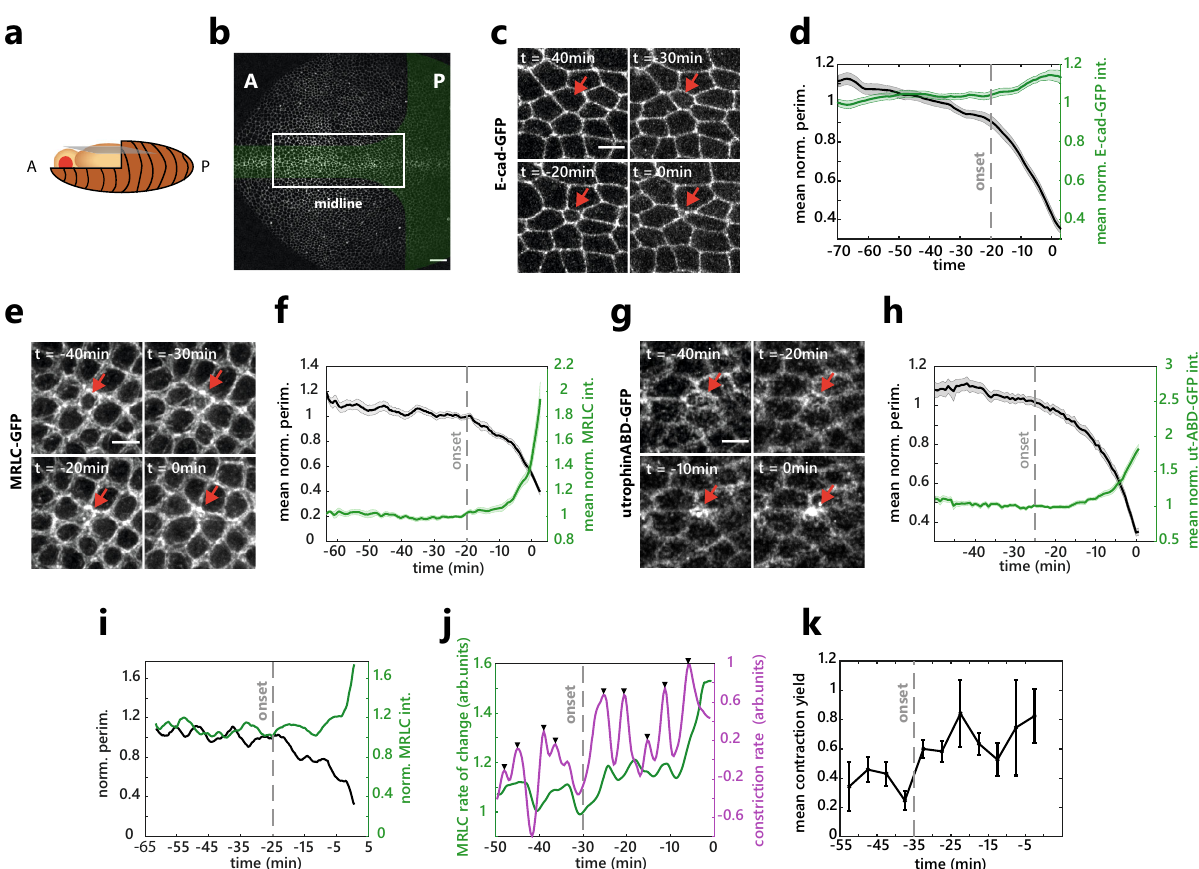
Fig. 1 Actomyosin modulation is not responsible for the initiation of cell extrusion. a Schematic of a Drosophila pupae. A: anterior, P: posterior. b Notum at 16 h after pupal formation (APF). Green zone: domains with a high rate of cell elimination, white rectangle: midline region. A: Anterior, P: Posterior. Scale bar, 25 µ m. c Snapshots of E-cad-GFP during cell extrusion. The red arrow shows an extruding cell. t 0 , time of extrusion termination (apical area = 0). Scale bar, 5 µ m. d Averaged and normalised E-cad-GFP junctional signal during cell extrusion (green) and cell perimeter (black), light colour areas are SEM. The curves were aligned temporally by using the extrusion termination time point (see “ Methods ” ). The grey dotted line represents the onset of extrusion marked by the in fl ection of the perimeter curve (see “ Methods ” ). N = 2 pupae, n = 27 cells. e Snapshots of sqh-GFP (MRLC) during cell extrusion. The red arrow shows an extruding cell. t 0 , time of extrusion termination. Scale bar, 5 µ m. f Averaged normalised sqh-GFP (MRLC) total signal (medial + junctional) during cell extrusion (green) and cell perimeter (black). The grey dotted line is the onset of extrusion, light colour areas are SEM. N = 2 pupae, n = 15 cells. g Snapshots of actin during cell extrusion (utrophin Actin-Binding domain fused to GFP, utABD-GFP). Red arrow points at an extruding cell. t 0 , time of extrusion termination. Scale bar, 5 µ m. h Averaged normalised utABD-GFP total signal (medial + junctional) during cell extrusion (green) and cell perimeter (black). Grey dotted line represents the onset of extrusion, light colour areas are SEM. N = 2 pupae, n = 37 cells. i Single-cell representative curve of sqh-GFP (MRLC) total signal (green) and perimeter (black) showing MRLC pulsatility and perimeter fl uctuations before and during cell extrusion. Grey dotted line represents the onset of extrusion. j Single-cell representative curve of sqh-GFP (MRLC) intensity rate of change (i.e., derivative, green) and the perimeter constriction rate (derivative of the perimeter, magenta). Black arrows show contraction pulses. Grey dotted line represents the onset of extrusion. k Averaged contraction yield (ratio of the constriction rate over MRCL junctional intensity) calculated in 5 min time windows (see “ Methods ” ). The dotted line, extrusion onset, and error bars are SEM. N = 2 pupae, n = 15 cells. Source data are provided in the source data fi